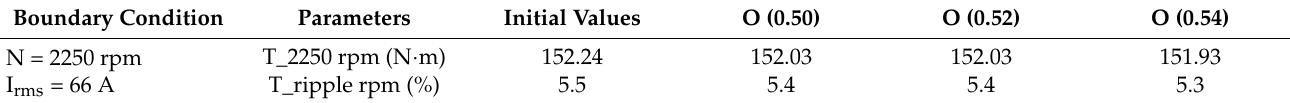
Table 9. Optimization design results of rotor rivet hole position.